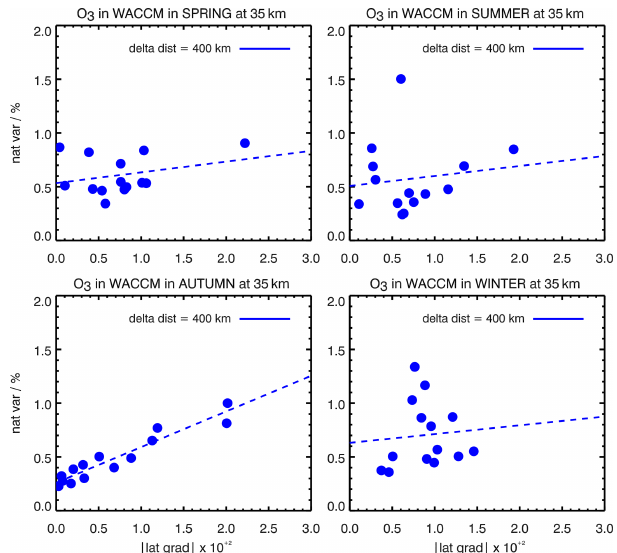
Figure 8. Natural variability of O 3 as a function of latitudinal gra- dients for a 400km distance separation at 35km altitude in four seasons in the WACCM